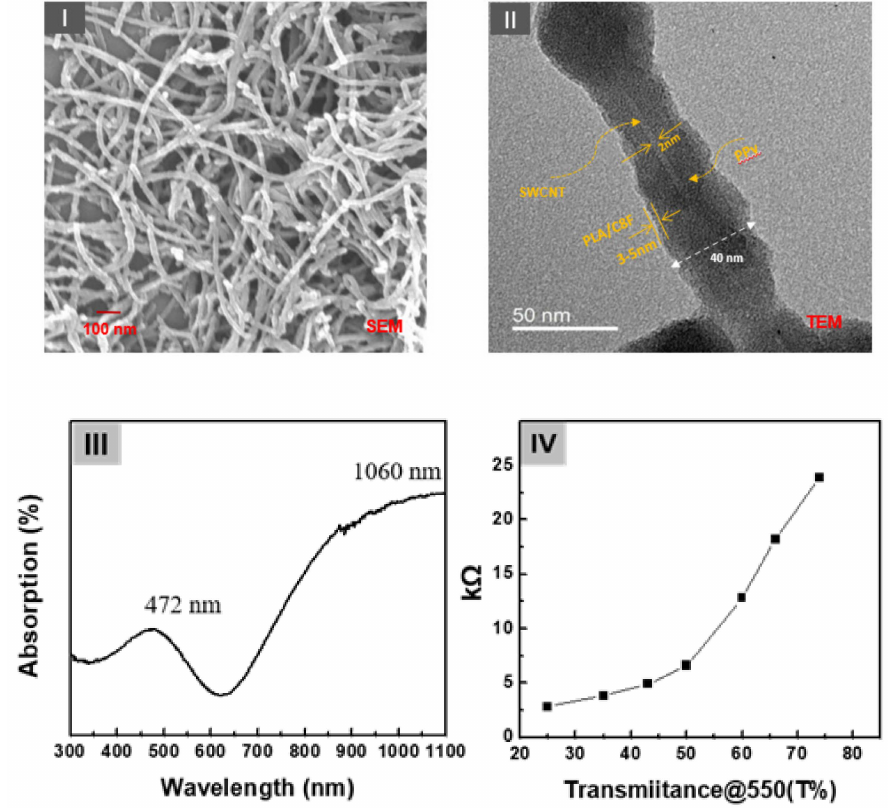
Figure 2. ( I ) The scanning electron microscopy (SEM) and ( II ) transmission core–shell-shaped nanorods (sample). ( III ) The surface plasmon absorption spectrum of the samples and ( IV ) the electrical resistance ( Ω ) of the sensor sample of the as-cast film formed as a function of the relative thickness (thickness converted concerning the light transmittance (%) at a 550 nm wavelength of the casting